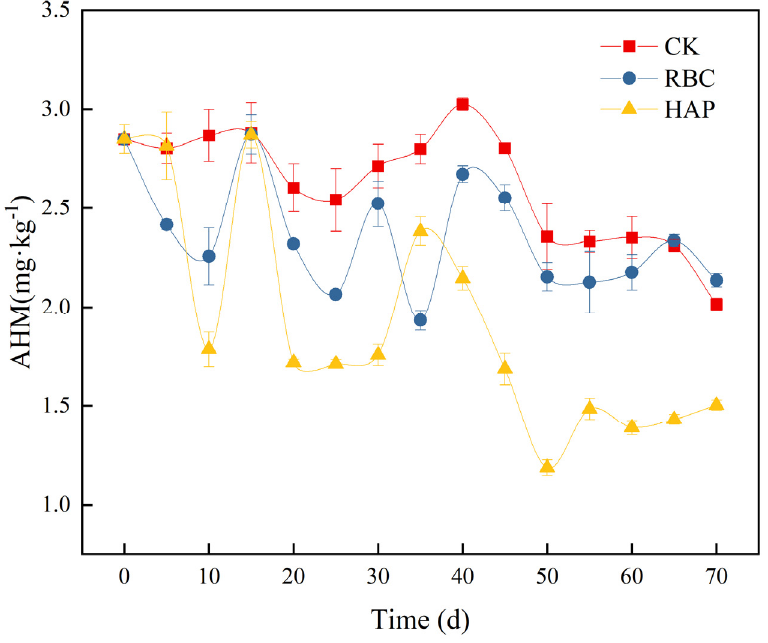
Figure 5. Dynamic change curve of AHM.